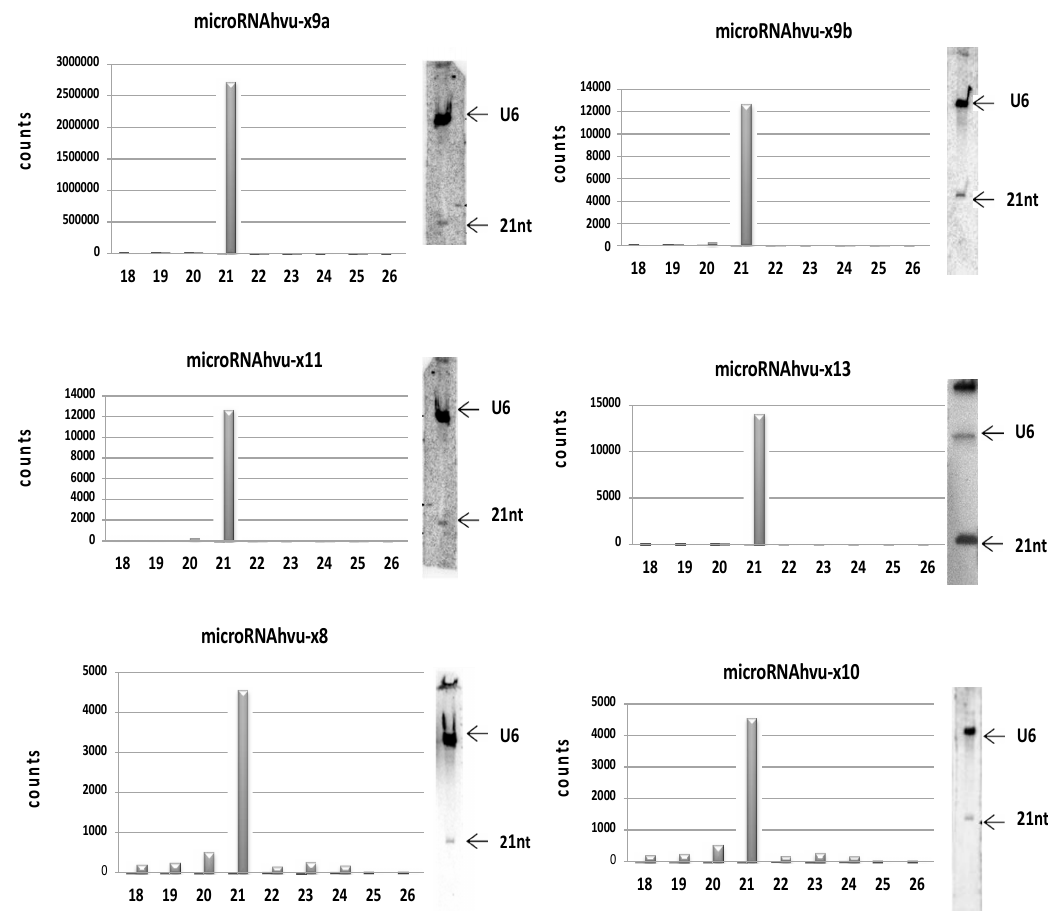
Figure 2. Distribution of counts for particular microRNAs in the cluster where y-axis represents normalized counts from sRNA libraries and x-axis presents length of particular small RNA in nucleotides (left panel) and validation of miRNA presence by Northern hybridization (right panel). In the case of microRNA microRNAhvu-x13 more sensitive hybridization method was used as described in Material and methods. U6 hybridization was used as loading control. Decade (Thermo Fisher Scientific) marker was used to estimate RNA fragment length. In right panels above the blots the name of each novel barley microRNA is provided. In the case of each microRNA left panel shows size distribution of small RNAs in a given cluster with the dominating cDNA fragment and mean counts from sRNA sequencing results from the 68-day-old plants.